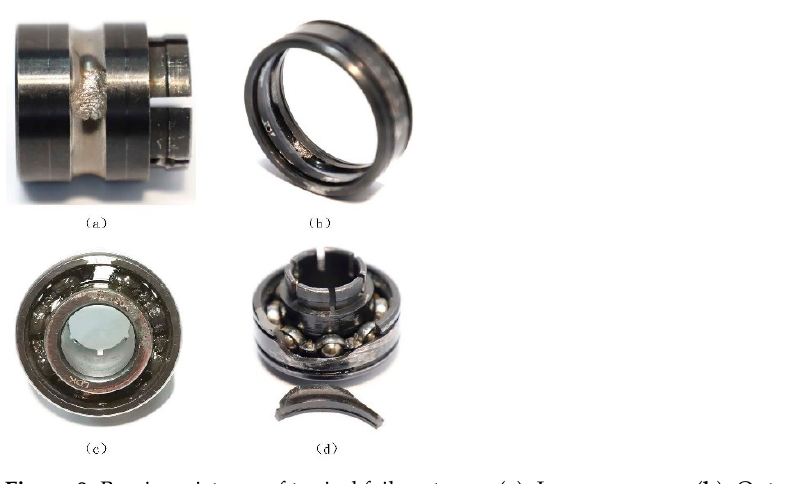
Figure 9. Bearing pictures of typical failure types. (a): Inner race wear (b): Outer race wear (c): Cage fracture (d): Outer race fracture